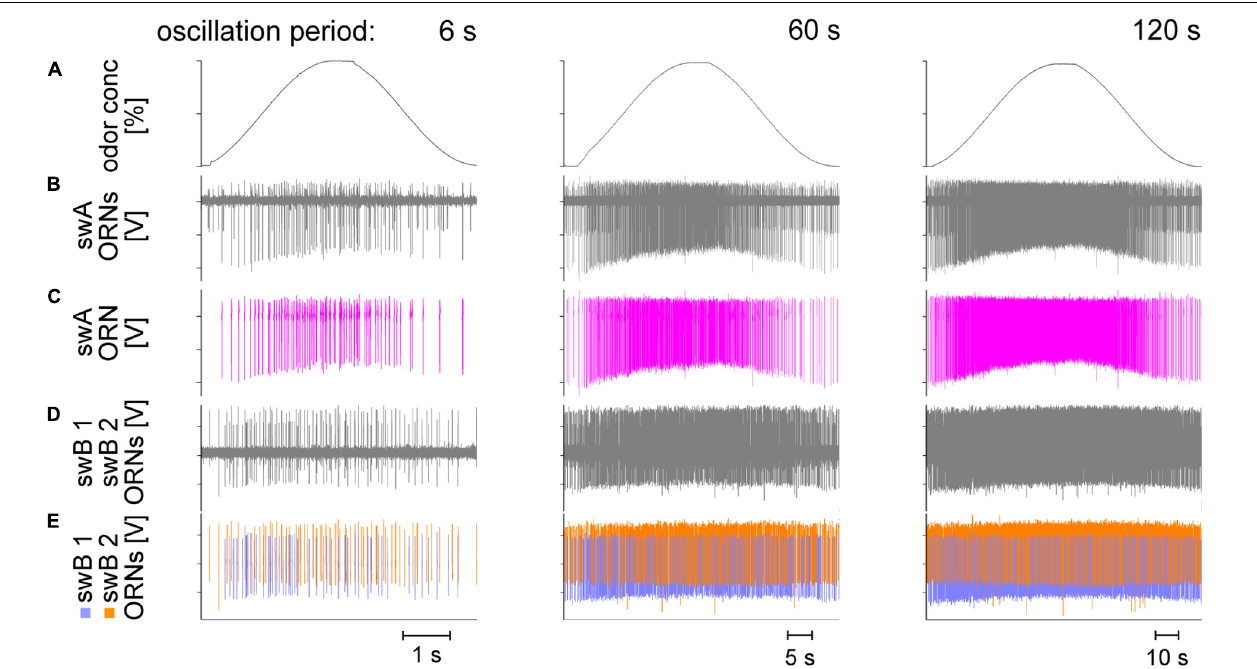
FIGURE 2 | Examples of recordings from a swA and swB sensillum type during slowly oscillating changes in the concentration of lemon oil odor. Oscillation periods are 6, 60, and 120 s. (A) Time course of odor concentration. (B) Recordings from the swA sensillum showed activities of two ORNs. (C) Only one ORN in the swA sensillum, producing larger amplitude spikes ( pink ), responded to oscillations in odor concentration. The rate of discharge of the ORN with the smaller impulse amplitudes remained unchanged (not shown in detail). (D) Recordings from the swB sensillum likewise revealed activities of two ORNs. Unlike the swA sensillum, both ORNs were activated by oscillations in odor concentration. (E) The ORN responding with the more negative amplitudes ( blue ) was referred to as swB1 ORN and that with the more positive amplitudes ( orange ) as swB2 ORN. (C,E) Off-line sorted action potentials obtained by spike detecting and template matching techniques using Spike2 software. Note that the increasing density of the action potentials with increasing duration of the oscillation period is due to the decreased time scales in the